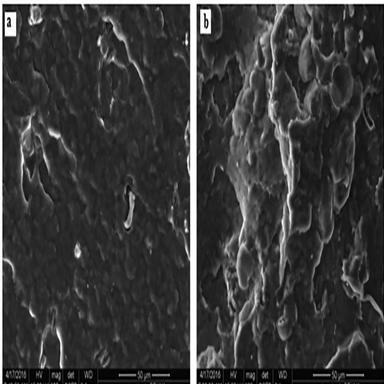
SEM micrographs. a) PCL/10% CP, b) PCL/10% CP /MAPE.